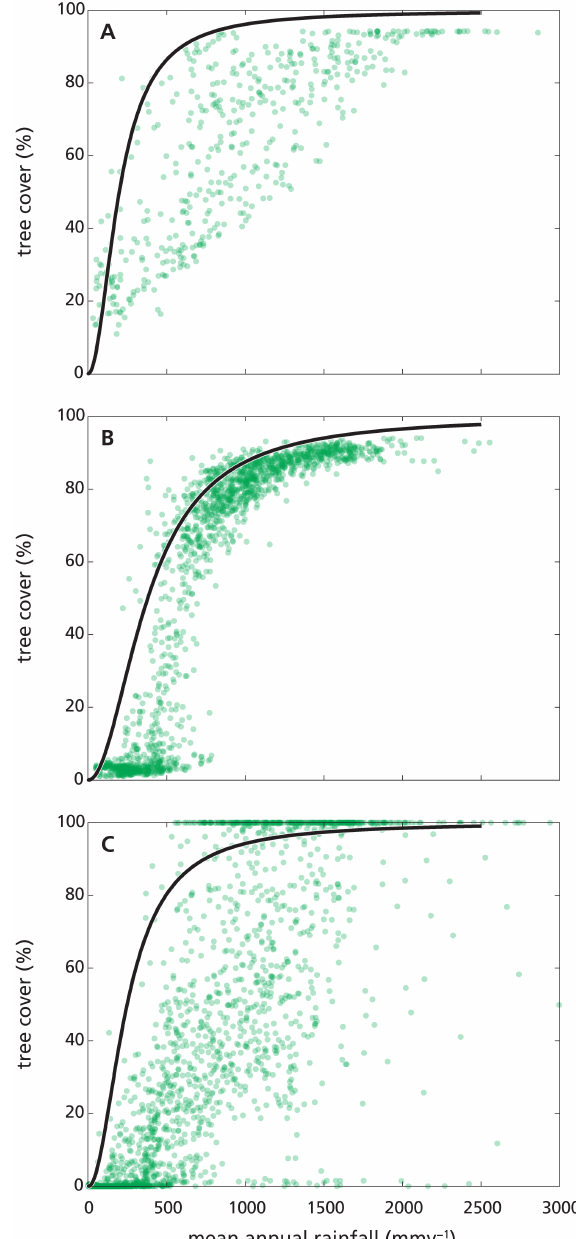
Figure 2. Model outputs for tree cover as a function of mean an- nual rainfall (mmyr − 1 ) in Africa between 35 ◦ S and 15 ◦ N: (a) JS- BACH; (b) LPJ-GUESS-SPITFIRE; (c) aDGVM. The dots are data, the continuous lines are the 90th quantile nonlinear regression (99th quantile not shown; see value of b coefficients in Table S1 in the Supplement). vides a schematic diagram of this feedback. At the highest end of the rainfall range, fires are totally suppressed and only forests are observed, since grass growth is inhibited by tree shade.